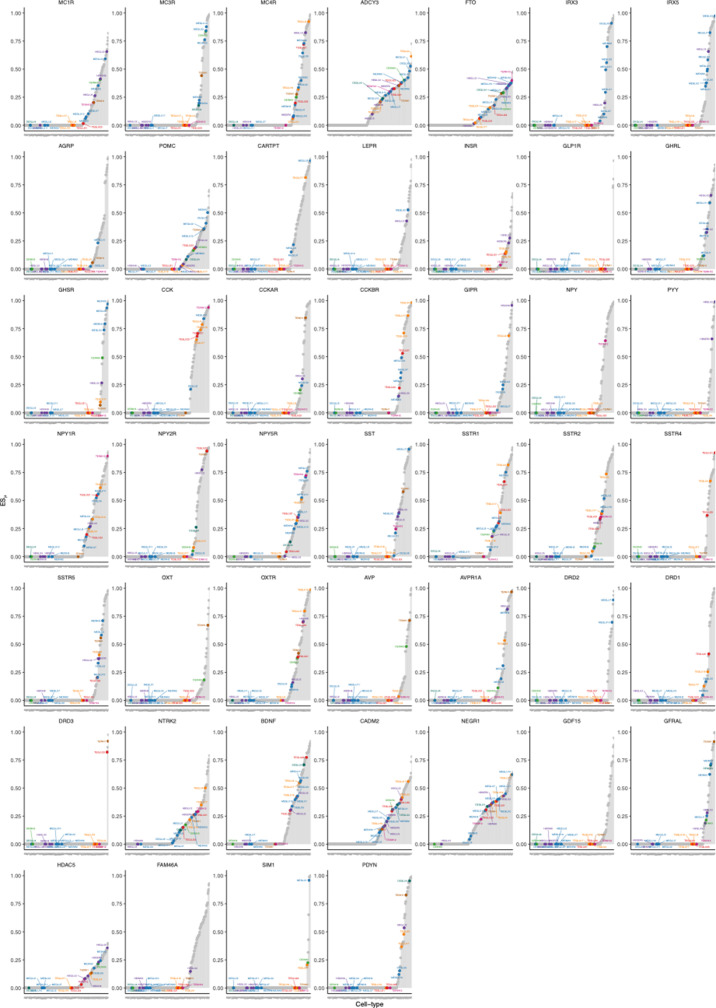
ESμ plot for selected genes ESμ plots for genes selected based on their suggested role in appetite regulation, energy homeostasis or obesity.The plot shows gene ESμ (y-axis) for each cell type (x-axis, ordered by increasing values of ESμ) and highlights the BMI-prioritized cell types.